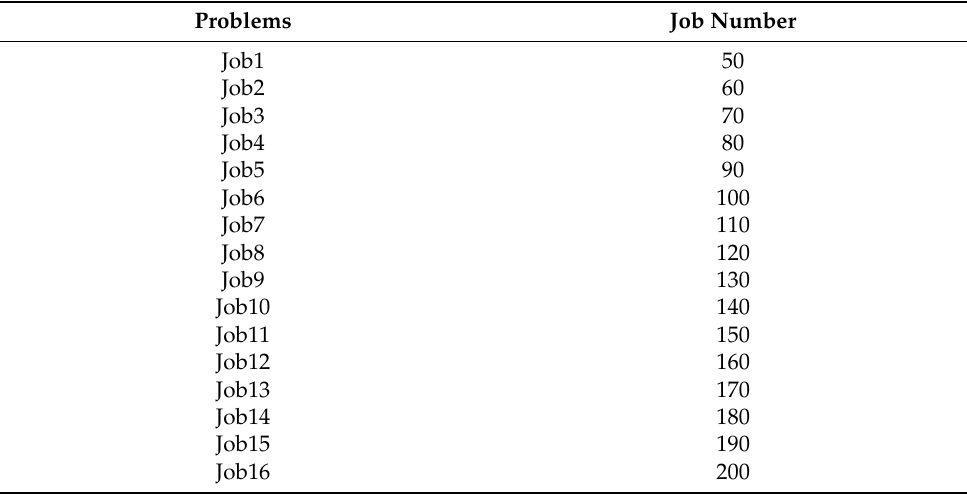
Table 2. The name and number of jobs of 16 scheduling